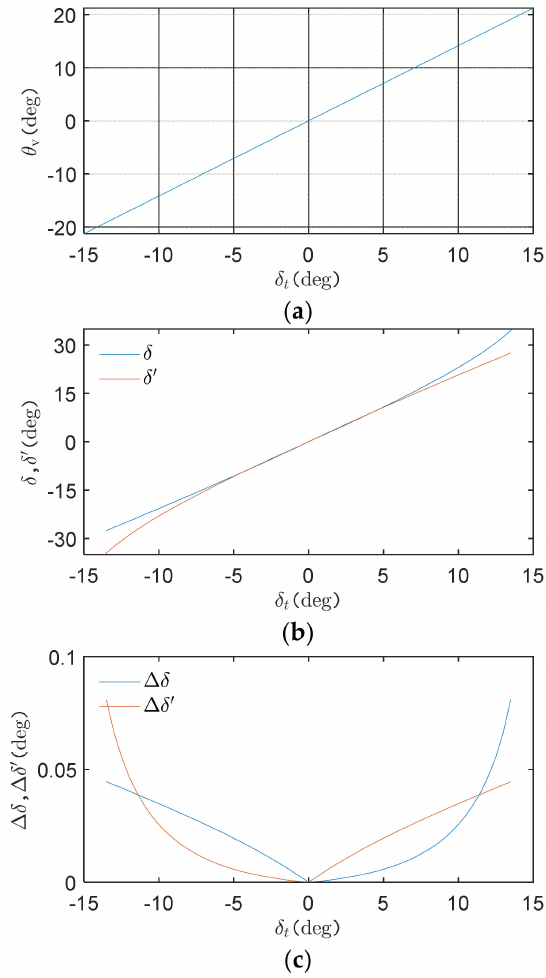
Figure 6. Simulation when the vehicle is driving. ( a ) θ v when the vehicle is steering; ( b ) δ (cid:48) and δ when the vehicle is tilting; ( c ) the error in δ (cid:48) and δ because of the tilting angle. Since the motion of the vehicle is symmetrical when turning to both sides, the vehicle steering to the left can be taken as an example. The SGCR ( K ) of the vehicle in this context is shown in Figure 7.